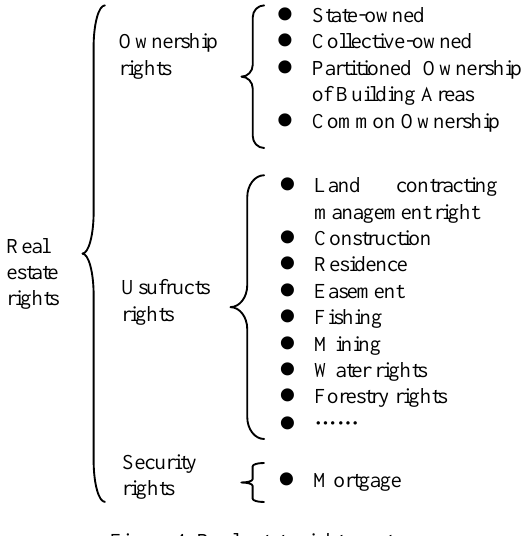
Figure 4. Real estate rights system